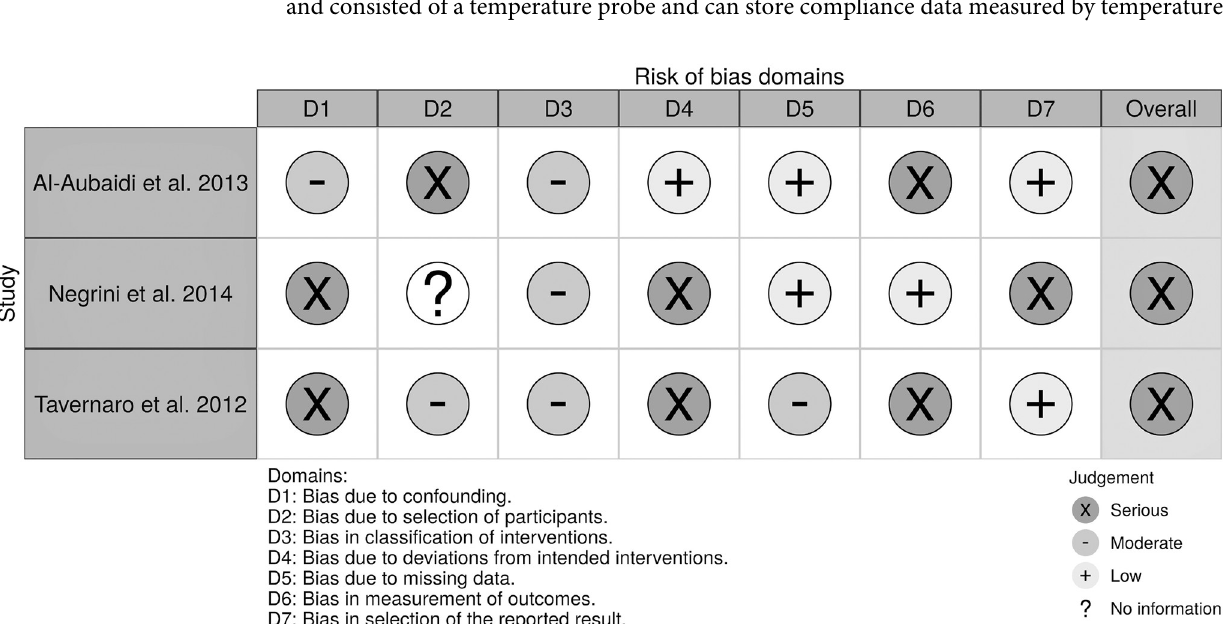
PLOS ONE | https://doi.org/10.1371/journal.pone.0271612 July 20,